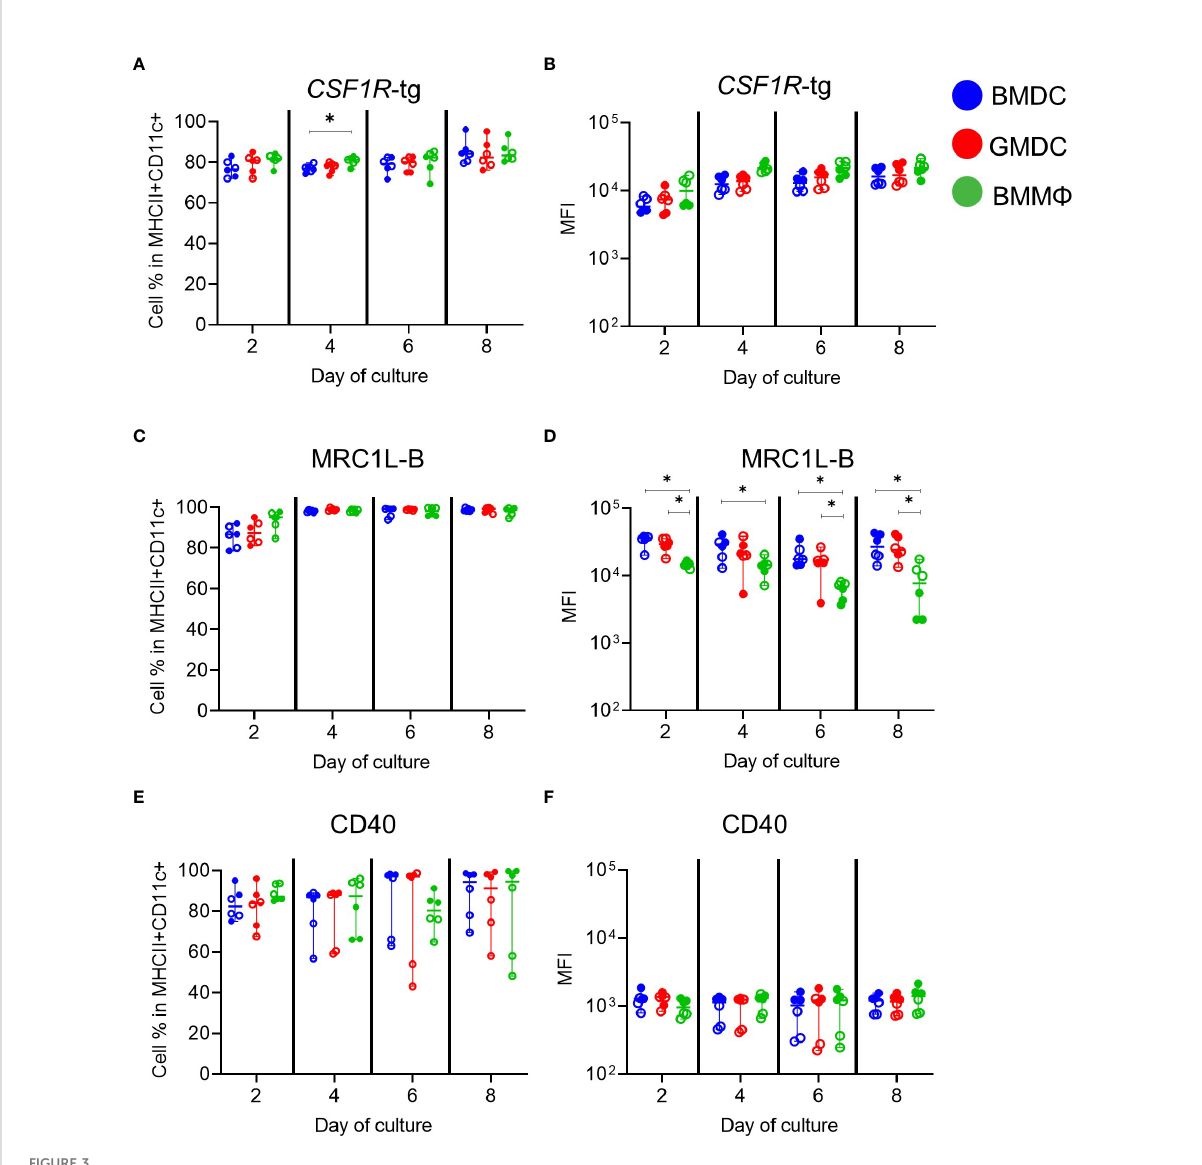
FIGURE 3 Phenotypic analysis of MHCII + CD11c + subpopulations in chicken BMDC, GMDC and BMM F cultures on days 2, 4, 6 and 8. The cell percentages and MFI of (A, B) CSF1R-tg, (C, D) MRC1L-B and (E, F) CD40 in the MHCII + CD11c + subpopulations in BMDC (blue), GMDC (red) and BMM F (green) on days 2, 4, 6 and 8. Data represents the median (± range). From each bird (n=6), BMDC, GMDC and BMM F were generated. Data represents two independent experiments (n=3 per experiment, open & closed circles). Statistical signi fi cant differences analyzed between cultures on day of analysis are indicated by